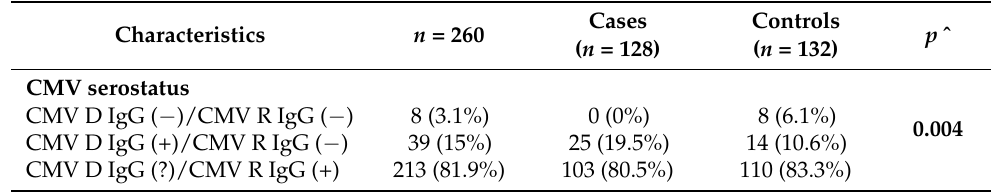
Table 3. CMV serostatus and detection of the first positive CMV viral load.